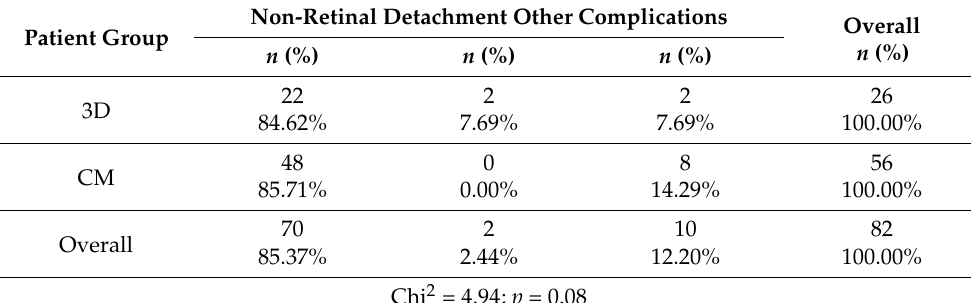
Table 3. Rate of postoperative complications in the three-dimensional viewing system (3D) and conventional microscope (CM) groups expressed in percent (%) and number of eyes ( n ). Patient